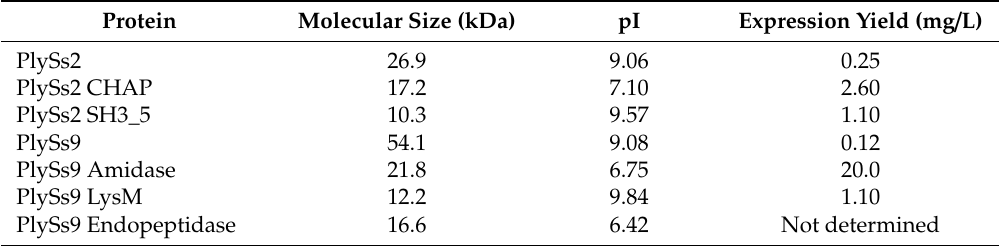
Table 1. Molecular size (kDa) and iso-electric point (pI) was calculated from the amino acid composition for each protein (see section material and methods) of the di ff erent proteins expressed and purified. The expression yield of the PlySs9 endopeptidase subdomain could not be determined, because it was expressed insolubly. Table 2. Forward and reverse primer sequences and their respective melting temperature (Tm) used to clone the individual subdomains from the parental endolysins by PCR. The coding sequence of the polyhistidine tag is underlined.